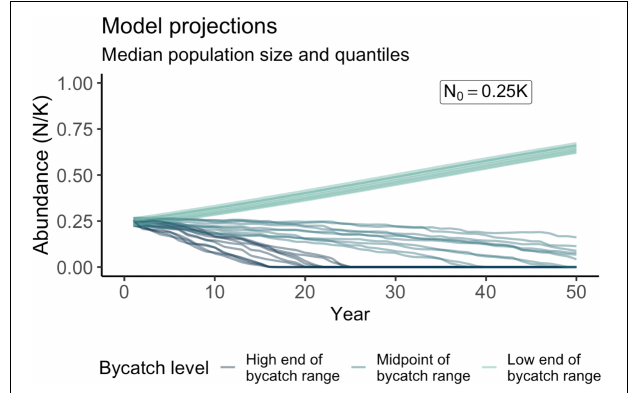
FIGURE 3 | An example of model projections for a bottlenose dolphin population, starting at 25% of carrying capacity, with a bycatch rate between 10 individuals per year (light green lines) to 1,300 individuals per year (dark blue lines). The lowest bycatch rate, which is below PBR for this theoretical population (PBR = 183 individuals), leads to a recovery to MNPL, which is set at half of the carrying capacity ( N/K = 0.5). For these projections, the starting population size is 20,000 individuals, the CV of abundance is 0.1, and the CV of bycatch is